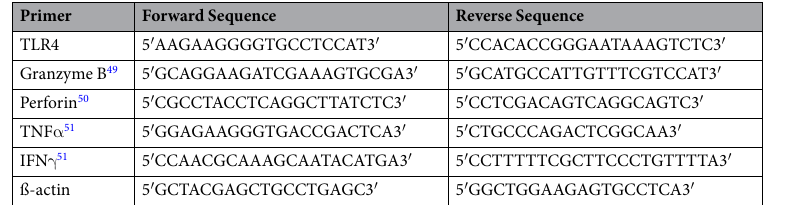
Table 2. List of primers used for quantitative real time